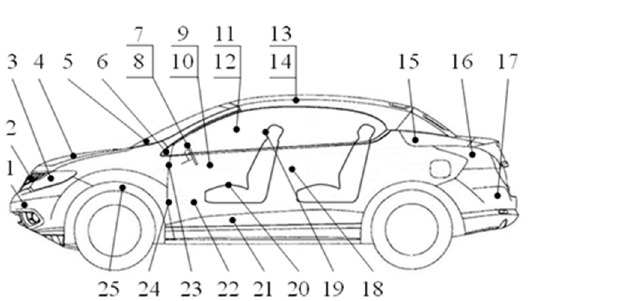
Figure 1. Schematic diagram for arrangement of temperature and humidity measuring points in automobiles.